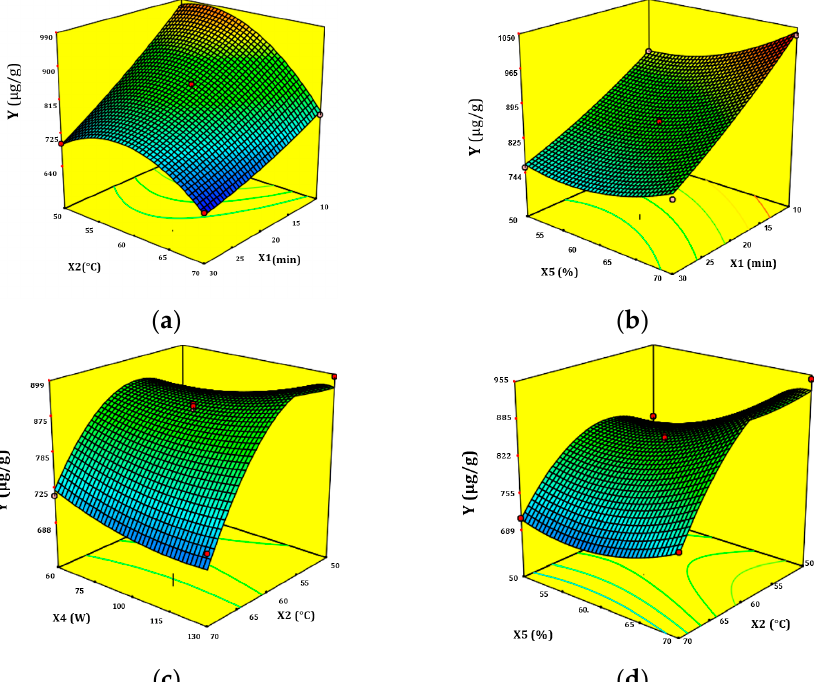
Figure 3. Response surface plots of the ISQ content (µg/g) of UAE as affected by the interaction between the pairwise factors: ( a ) ultrasonic time (X1) and ultrasonic temperature (X2), ( b ) EtOH concentration (X5) and ultrasonic time (X1), ( c ) ultrasonic power (X4) and ultrasonic temperature (X2), ( d ) EtOH concentration (X5) and ultrasonic temperature (X2).